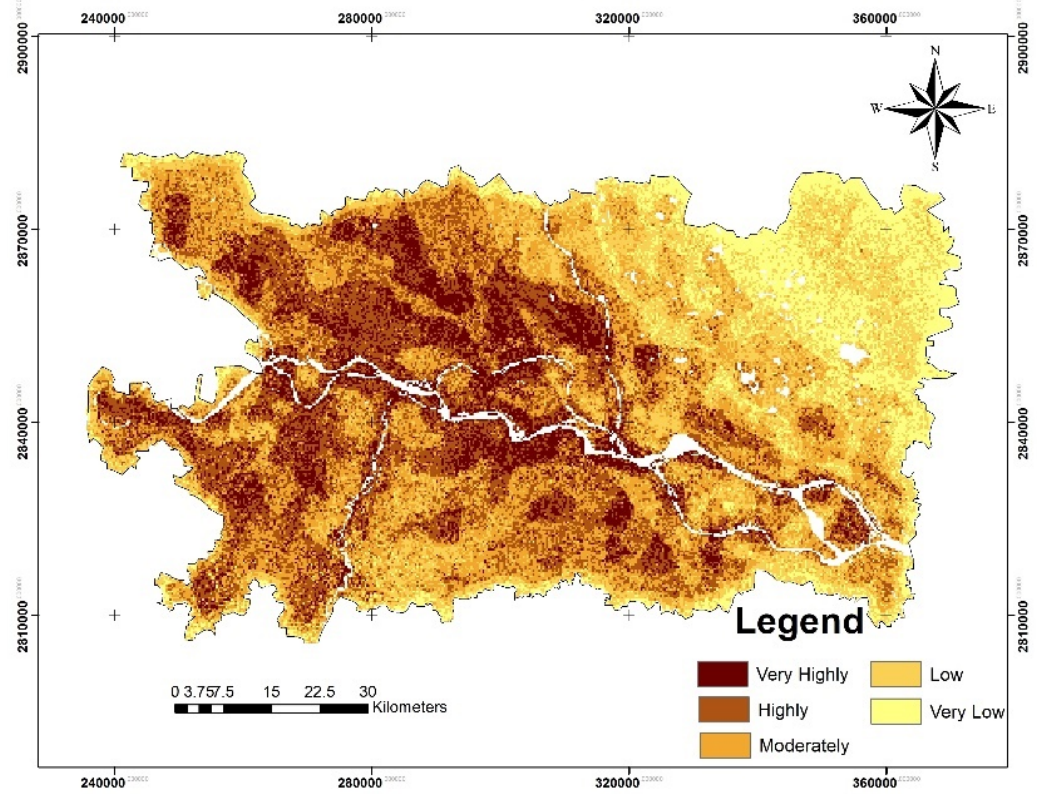
Figure 5. Final flood susceptibility map.